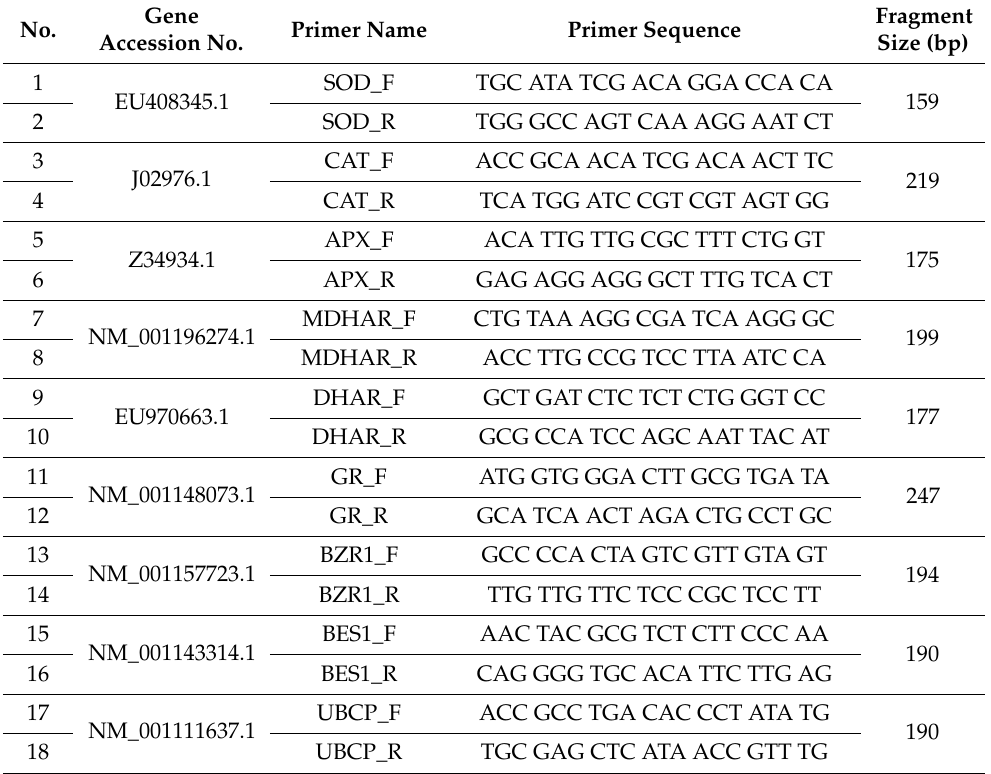
Table 2. Primer sequences used for gene expression